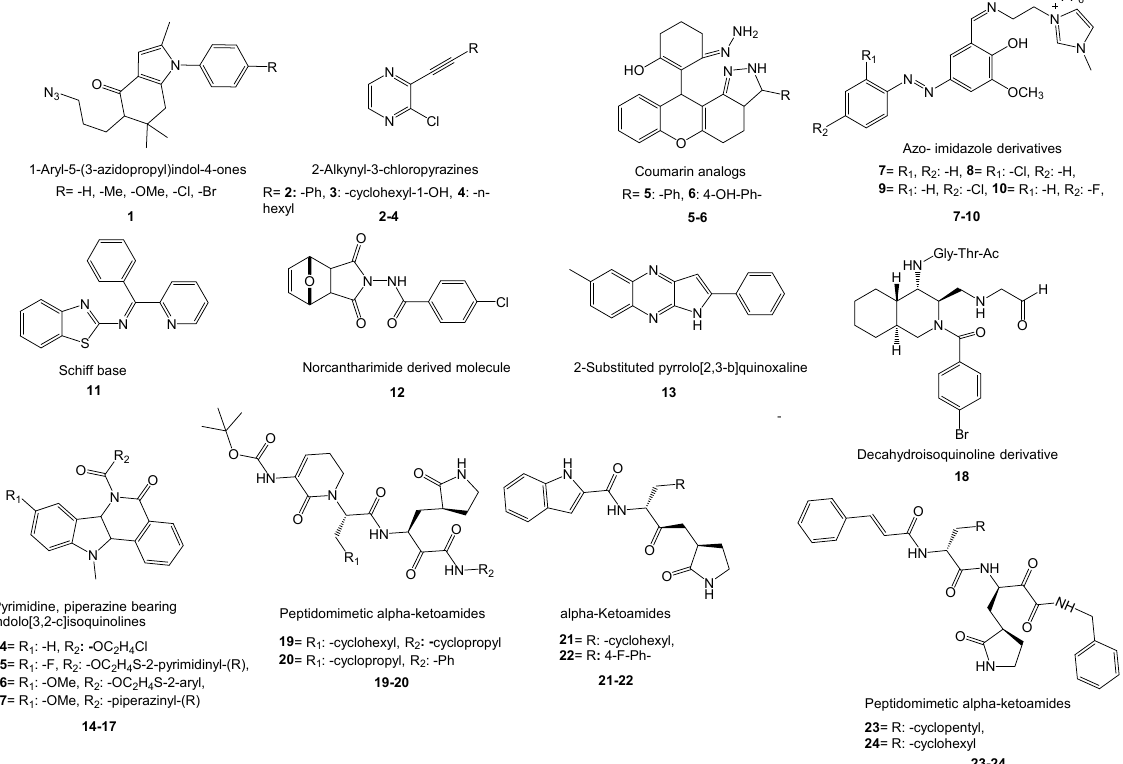
Figure 6. New molecules with anticipating anti-COVID-19 properties.